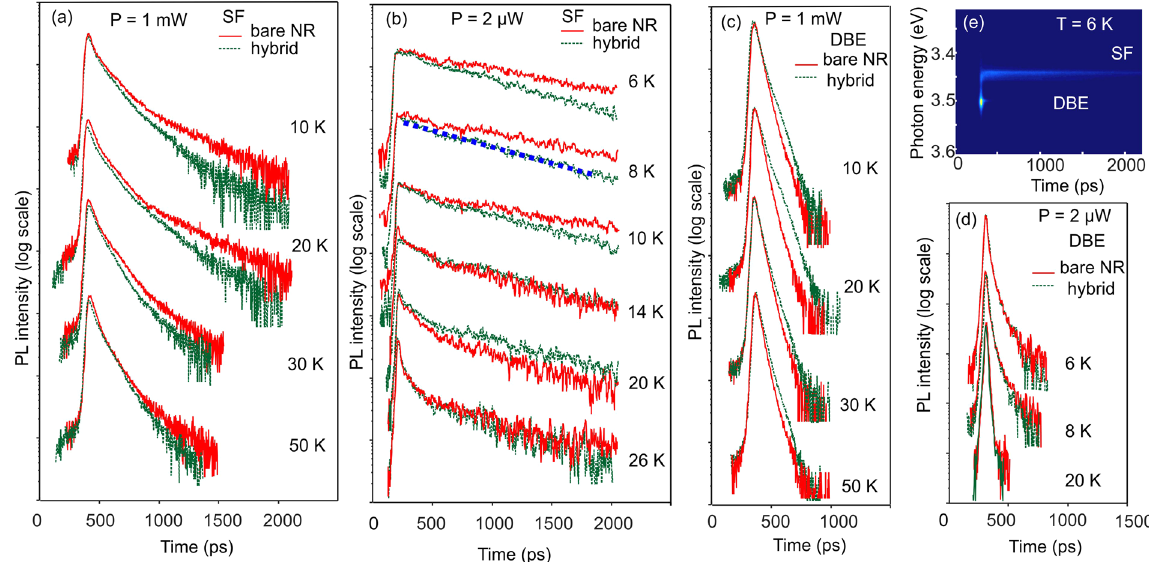
Figure 3. Decay curves taken at peak position of the SF related emission ( a , b ) and DBE emission ( c , d ). Red solid and green dashed curves are relate to as-grown GaN NRs (bare NR) and to the hybrid, respectively. ( e ) TRPL spectrum taken at 6 K. Measurements in ( a , c ) are performed at 1 mW laser power, the data in ( b , d , e ) were obtained at 2 µ W excitation power. The blue thick dashed line in ( b ) shows an example of fitting using single exponential